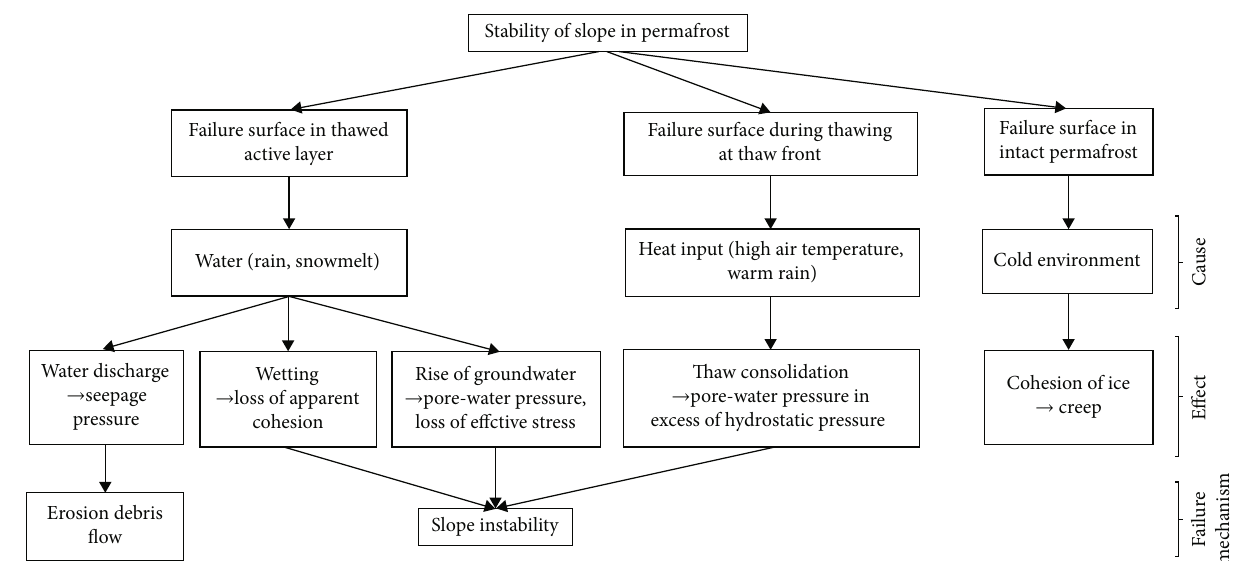
Figure 6: Possible causes, e ff ects, and failure mechanisms of slopes in permafrost environments